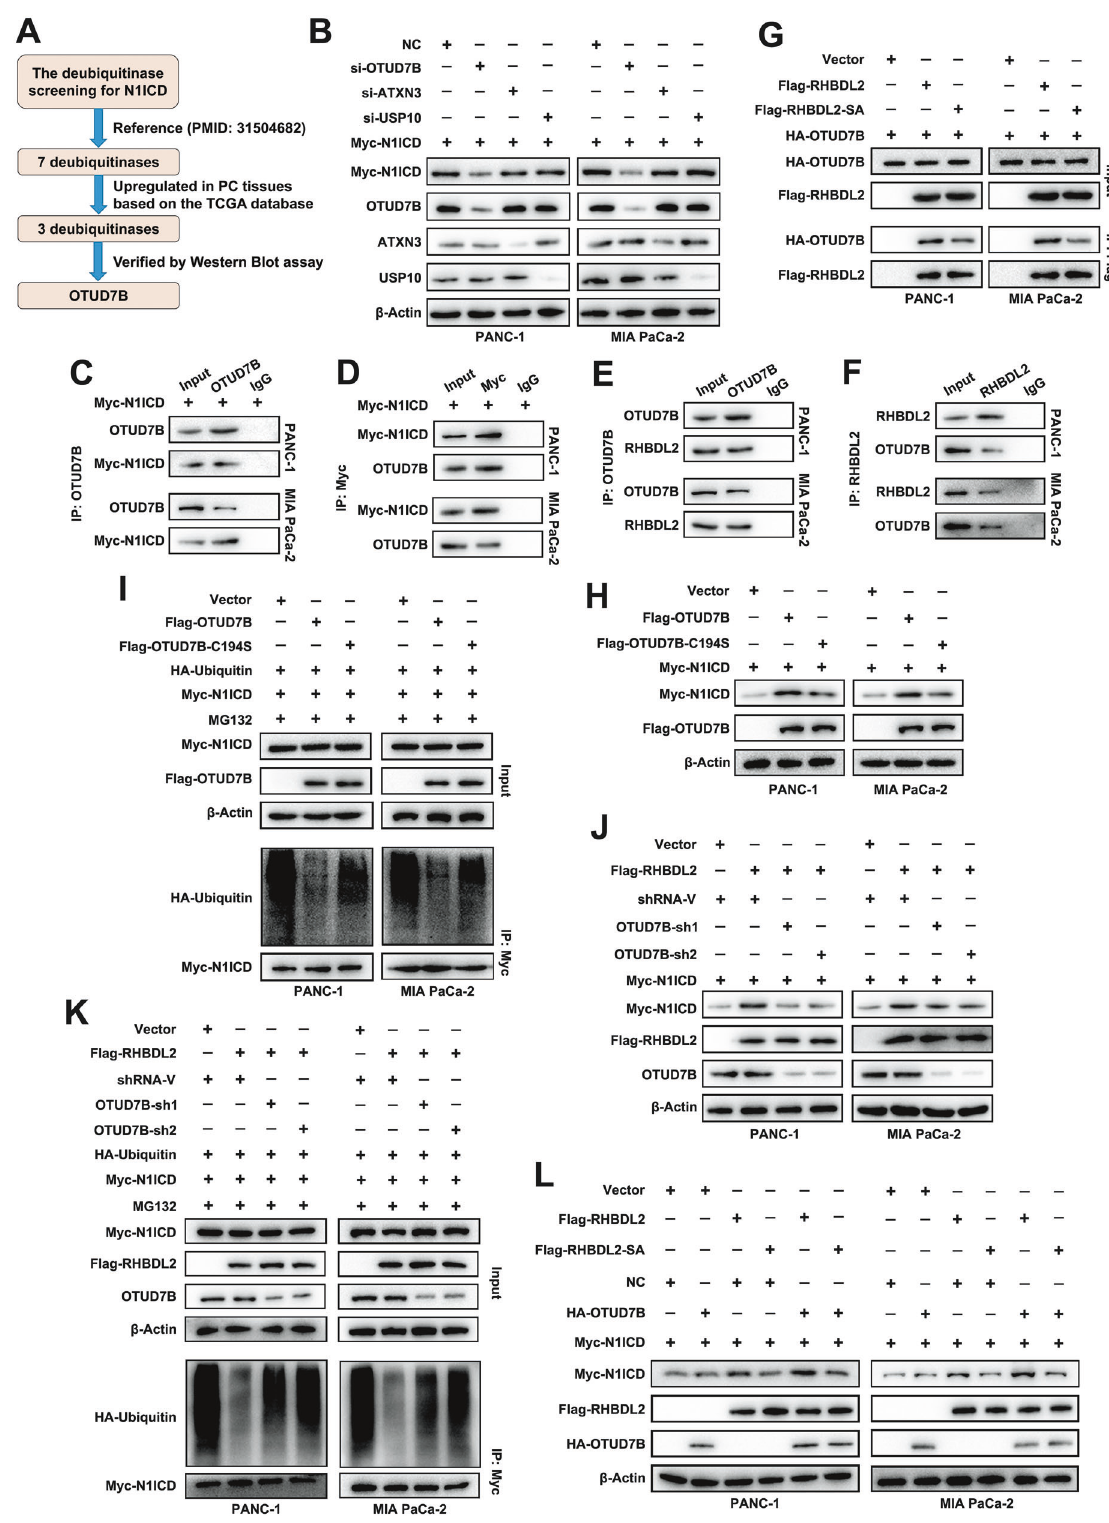
Fig. 6 RHBDL2 stabilizes the N1ICD via the OTUD7B. A The deubiquitinase screening procedure for N1ICD. B Western blot analysis was performed to measure the expression levels of N1ICD, OTUD7B, ATXN3, and USP10 in the indicated PC cells. Immunoprecipitation assay of OTUD7B and N1ICD ( C – D ), OTUD7B and RHBDL2 ( E – F ). G The expression levels of HA-OTUD7B and Flag-RHBDL2 were con fi rmed by immunoprecipitation. H The levels of N1ICD and Flag-OTUD7B were determined by Western blot assay. I The PC cells were treated with 15 μ M of MG132 for 6 h prior to harvest. The cell lysate was immunoprecipitated with Myc-tag antibody and immunoblotted as indicated. J The levels of N1ICD, Flag-RHBDL2, and OTUD7B in the indicated PC cells were detected by Western blot assay. K The PC cells were treated with 15 μ M of MG132 for 6 h prior to harvest. The cell lysate was immunoprecipitated with Myc-tag antibody and immunoblotted as indicated. L The expression levels of N1ICD, RHBDL2, and OTUD7B in the indicated PC cells were determined by Western blot assay. Cell Death and Disease (2022)